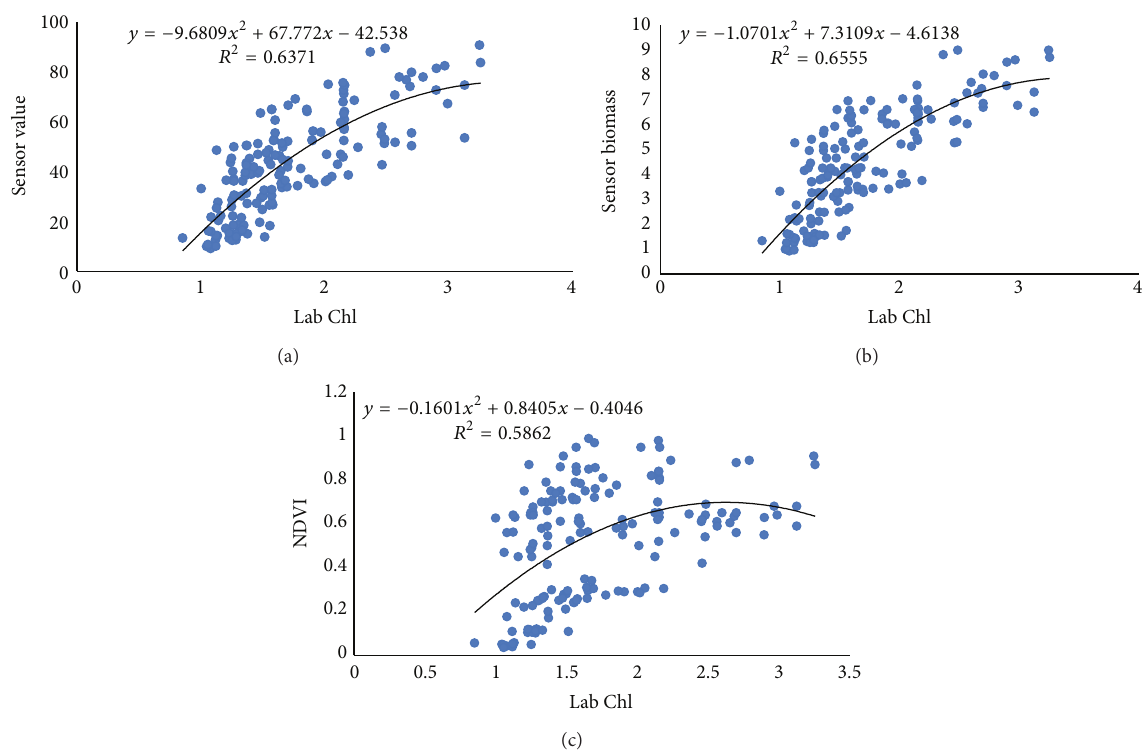
Figure 16: Correlations between different sensor attributes and Lab Chl for complete crop growth.